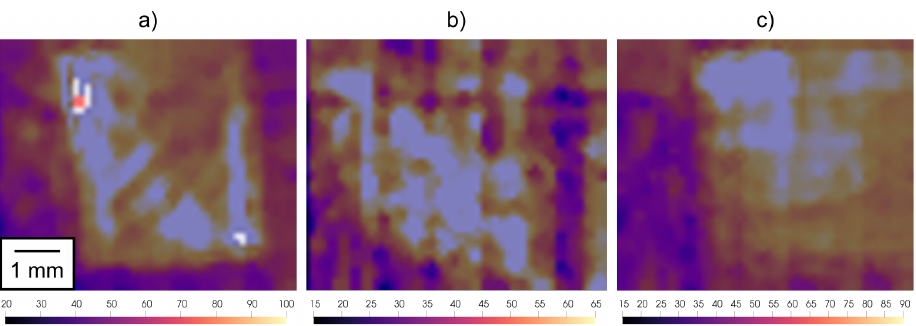
Figure 10. Thermograms captured in the initial stages of the compression for all the orientations of the specimens: ( a ) 0 ◦ , ( b ) 45 ◦ , and ( c ) 90 ◦ .